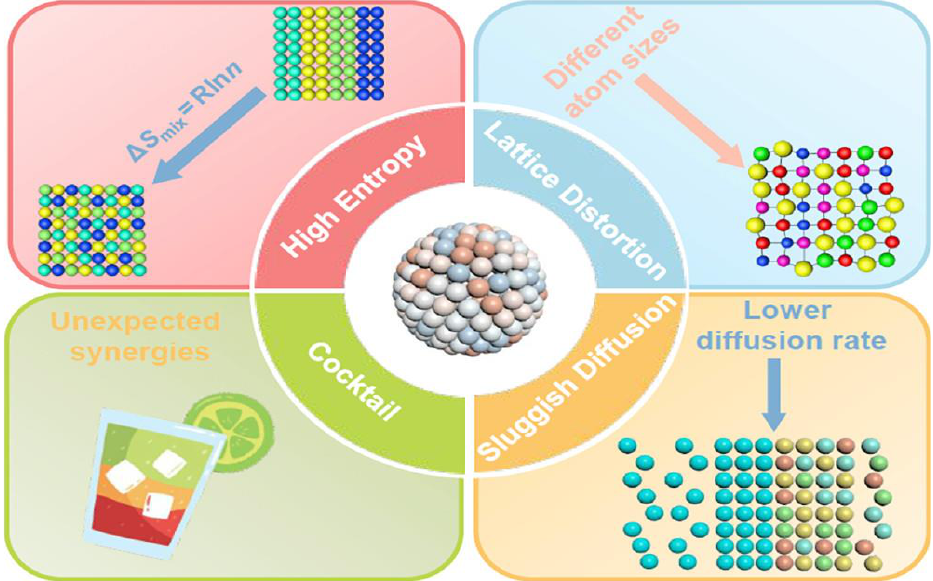
Figure 16. Schematic representation of the characteristics of HEA. (Reprinted with permission from [241]. Copyright 2020, American Chemical Society).